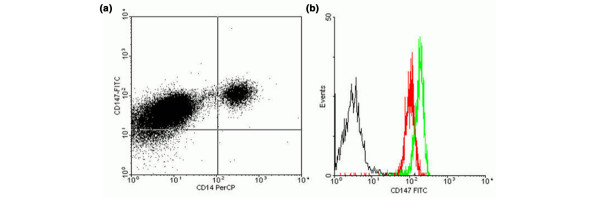
Flow cytometry analysis of CD147 expression on CD14+ cells of peripheral blood. (a) CD14 (x-axis) and CD147 (y-axis) staining of leukocytes in peripheral blood of RA patients. In CD14+ cells, the percentage of CD147 positive staining cells was 98.53 ± 2.09%. (b) Expression of CD147 on CD14+ cells of peripheral blood in RA and normal control group. The black line shows the isotype control, the red and green lines shows anti-CD147 antibody staining in the normal control and the RA group, respectively. The mean fluorescence intensity (MFI) of CD147 expression on CD14+ cells was higher in the RA than in the normal control group.